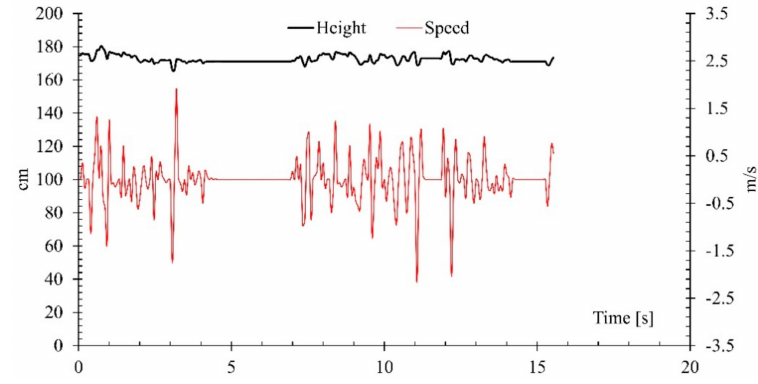
Figure 4. Changes in height with instant walking speed.